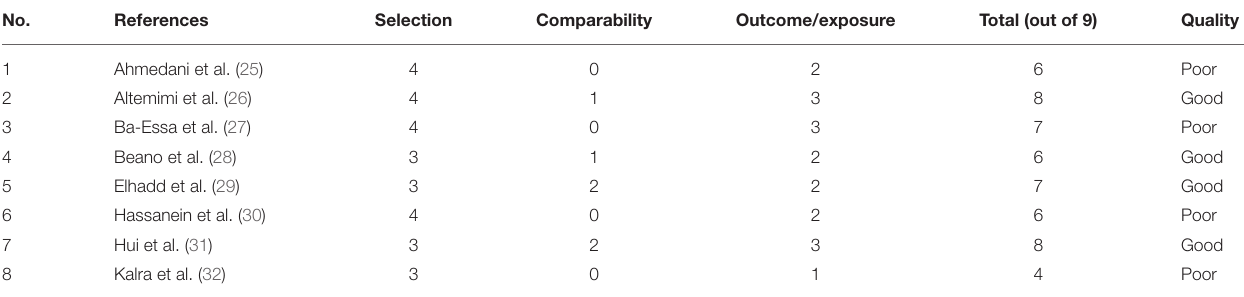
TABLE 5 | Newcastle-Ottawa Scale for the risk of bias and quality assessment of cohort studies. No.